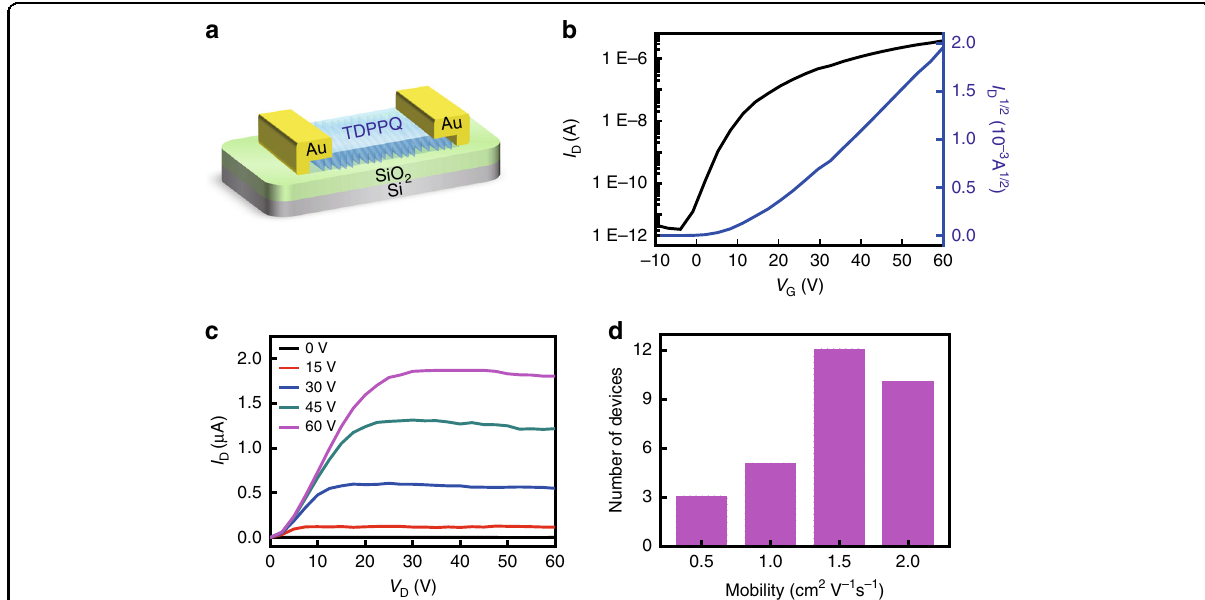
Fig. 3 The self-assembled TDPPQ-nanosheet-based organic fi eld-effect transistor. a The schematic illustration of the TDPPQ-nanosheet-based top-contact bottom-gate organic transistor. b Transfer characteristic of a representative device. c Output characteristic of a representative device. d Mobility distribution of the TDPPQ-nanosheet-based